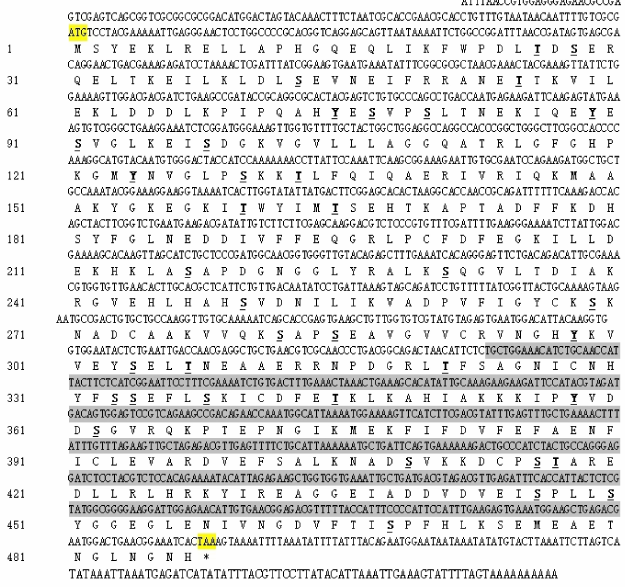
Figure 1. Nucleotide and deduced amino acid sequence of CmUAP cDNA. The start codon and stop codon are marked in yellow, the phosphorylation sites are marked in underlined bold font, and target sequence for RNAi is